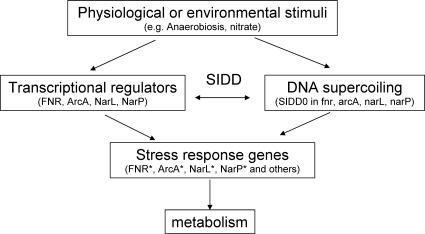
Proposed Model of SIDD-Mediated Transcriptional RegulationStrong SIDD sites are proposed to be important regulatory elements for global gene expression in response to environmental or physiological stresses.doi: 0.1371/journal.pcbi.0040017.g007